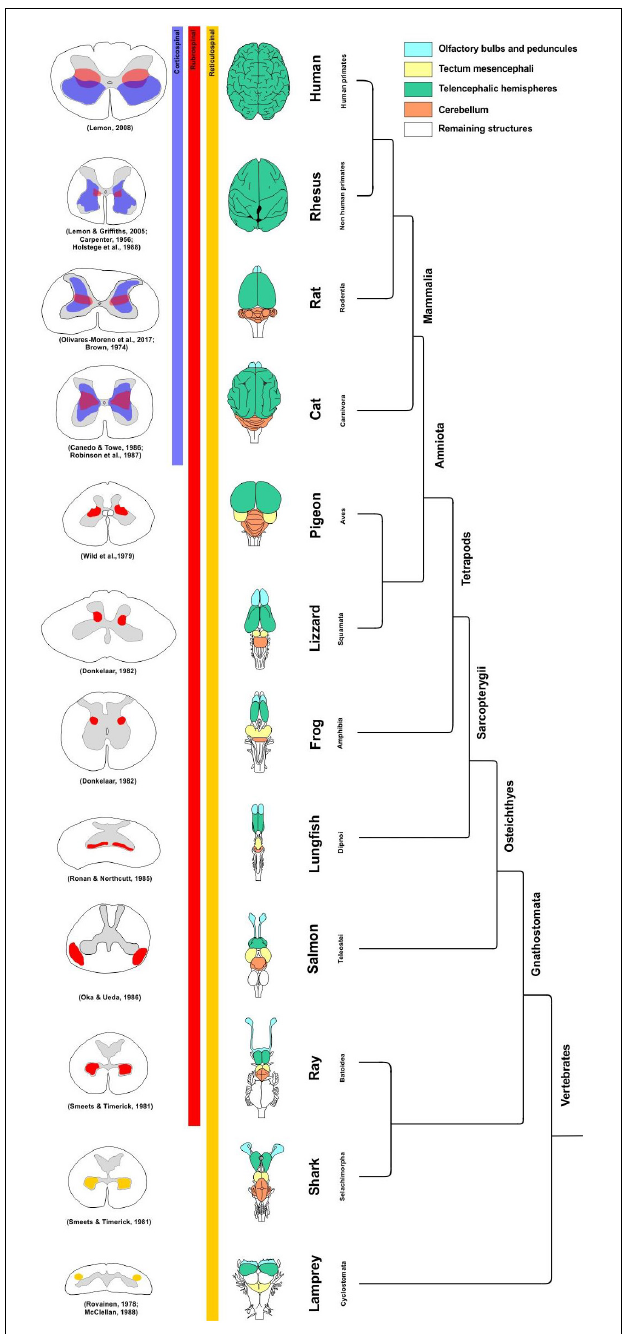
FIGURE 1 | Phylogenetic relationship among the main groups of vertebrates. The drawings show a dorsal view of the brain of representative species of each group, as well as a transverse section of the spinal cord. Ancient vertebrates without RS and CS projections received only descending reticulo-spinal projections (yellow). The shadows in the spinal cord gray matter indicate the zones where rubrospinal (red) and corticospinal (blue) fibers terminate in each group. The data supporting the RS and CS terminals in the spinal cord are indicated (Carpenter, 1956; Brown, 1974; Rovainen, 1978; Wild et al., 1979; Smeets and Timerick, 1981; Ten Donkelaar, 1982; Ronan and Northcutt, 1985; Oka et al., 1986; Robinson et al., 1987; Holstege et al., 1988; McClellan, 1988; Lemon, 2008; Olivares-Moreno et al.,